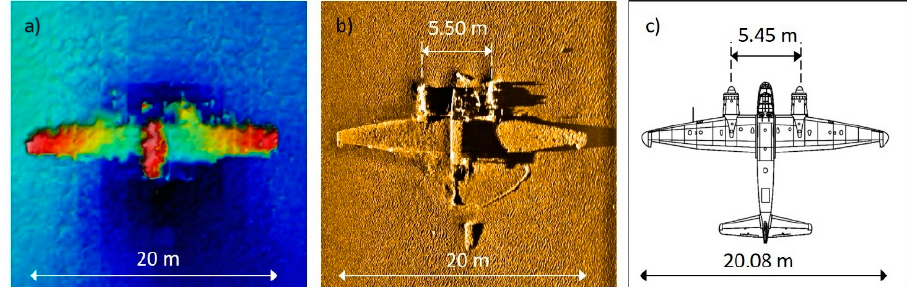
Figure 16. Comparison of the wingspan and distance between engines: ( a ) data recorded with MBES; ( b ) sonar imagery and dimensioning; ( c ) actual dimensions of the Junkers Ju 88.